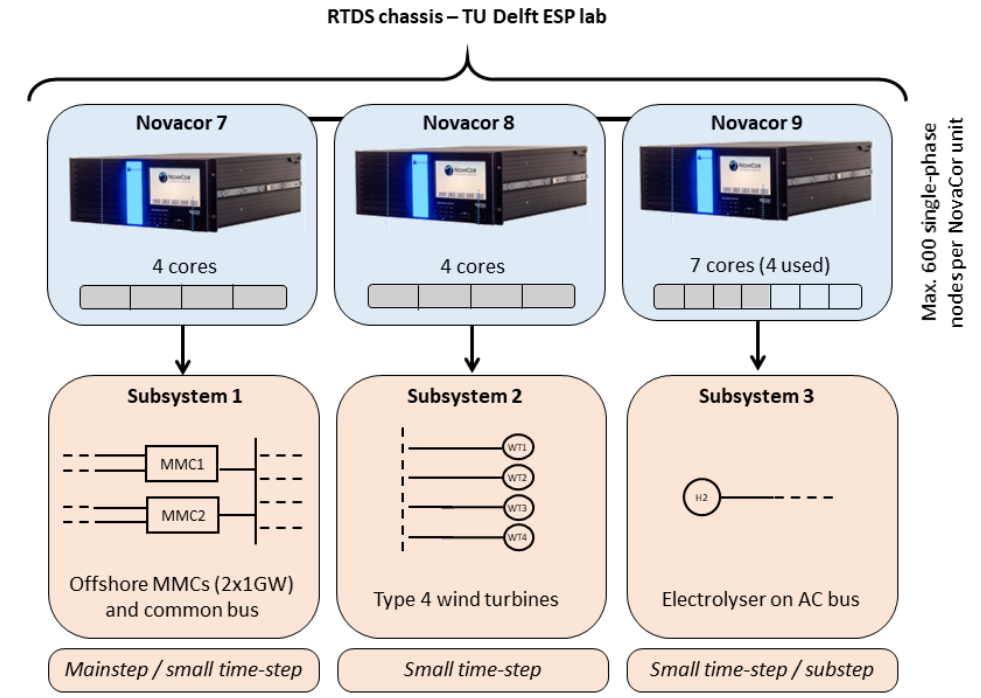
Figure 10. RSCAD ® core assignment in Scenario 2.